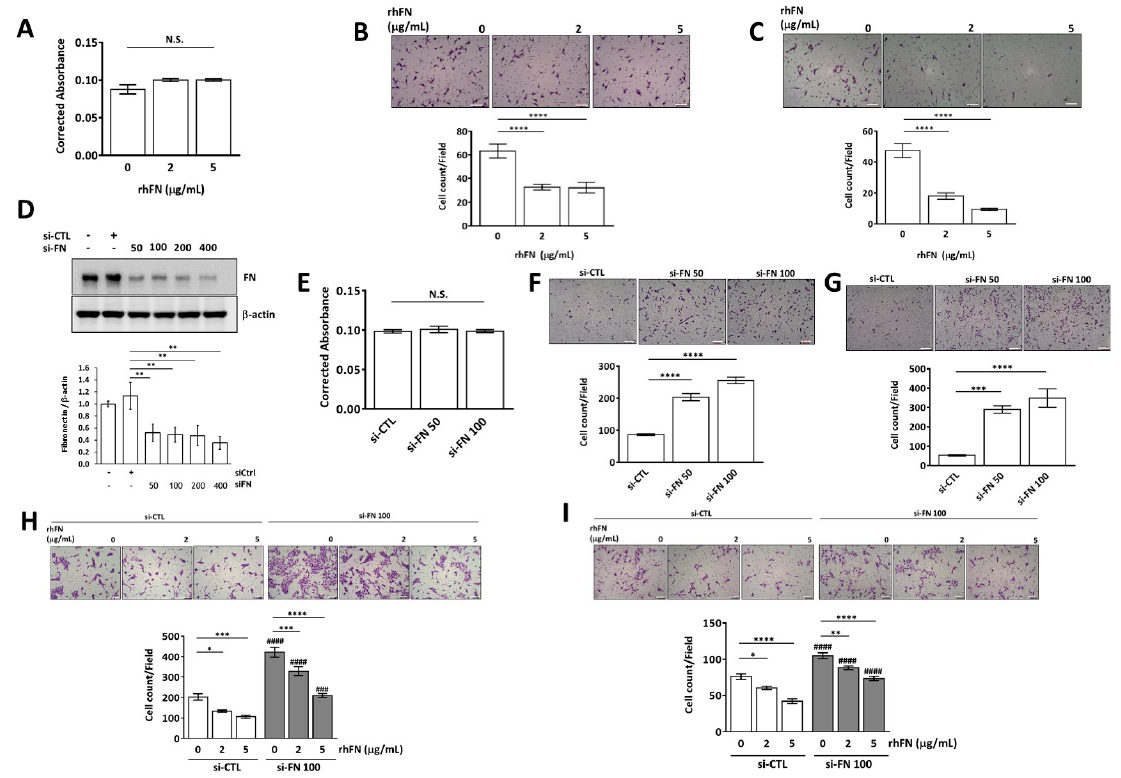
Figure 2. Fibronectin (FN) inhibits trophoblast migration and invasion without affecting cell viability. HTR-8/SVneo cells were treated with fibronectin (0, 2, and 5 µ g/mL, rhFN) in serum-free medium for 24 h and then processed for ( A ) cell viability measurements after 24 h of culture and ( B , C ) cell migration and invasion assays for the next 24 h using a transwell system. HTR-8/SVneo cells were transfected with scrambled siRNA (si-CTL) or si-FN for 24 h, and cells were subjected to ( D ) cellular FN expression in the cell lysate using Western blotting and quantification of Western blotting, ( E ) cell viability, ( F ) cell migration, and ( G ) cell invasion assays. After FN knockdown in HTR-8/SVneo cells with si-FN for 24 h, cells were treated with rhFN (5 µ g/mL) for another 24 h before ( H ) migration and ( I ) invasion assays. Data are presented as the mean ± SEMs. N.S. denotes no